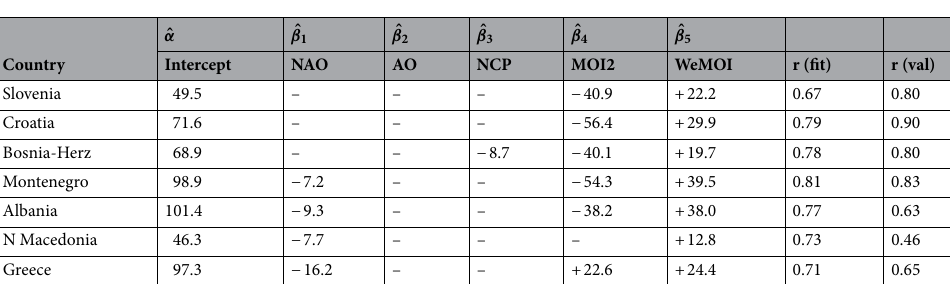
ˆ β ˆ Y ˆ Y = ˆ α + ˆ β X X denoting 1 1 + · · · + 5 5 , with